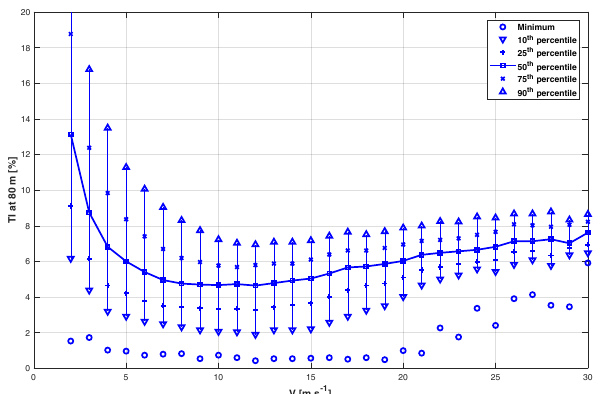
Figure 16. Minimum value, 10th, 25th, 50th, 75th and 90th TI per- centiles as functions of wind speed at 80m above the water line at FINO1 from September 2003 to August 2007. Data taken from Türk and Eimeis (2010). Figure 17. TI PDF (a) and CDF (b) at 9ms −